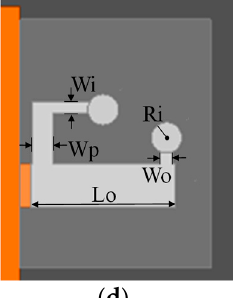
Figure 1. Top view of the proposed filter: ( a ) using two split-ring resonators (SRR); ( b ) with stub; ( c ) with stub and microfluidic channel; and ( d ) an enlarged top view of the microfluidic channel.